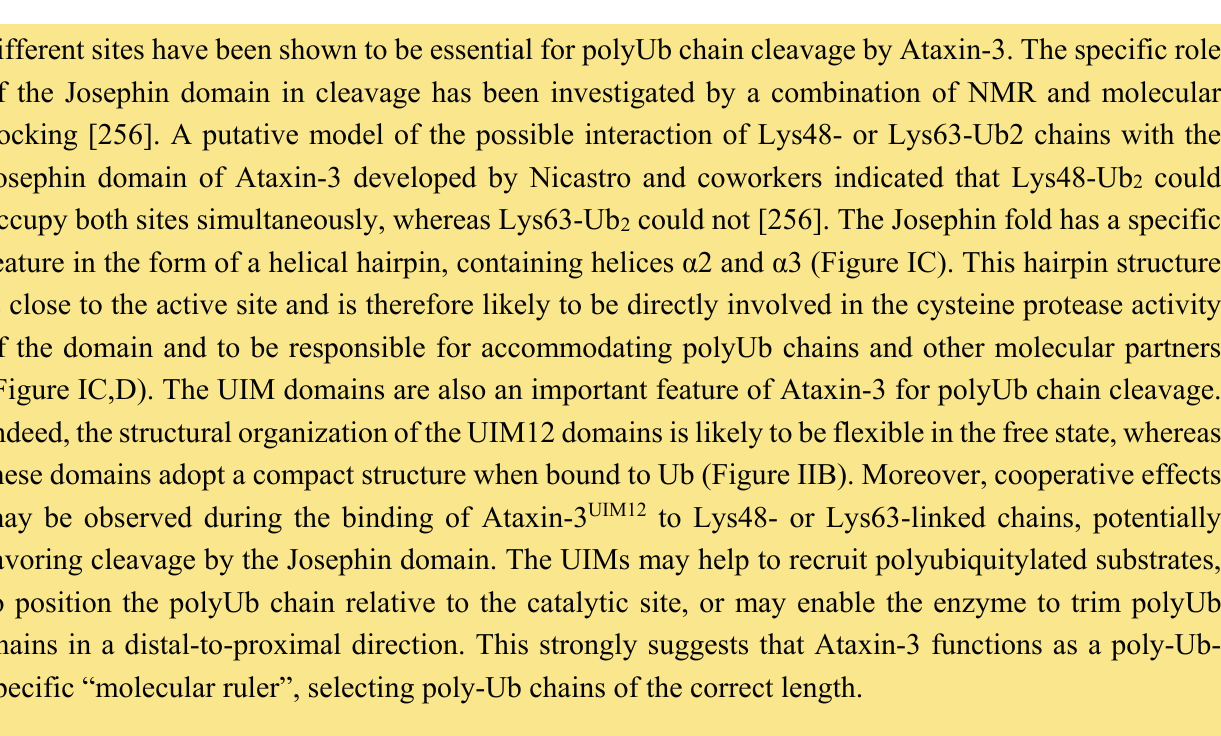
Figure II. Structures of the Ataxin-3 Josephin/Ub ( A ) binary complexes, showing the two binding sites available on the Josephin domain. ( B ) Upon binding to polyUb chains, the Ataxin-3 UIM12 domains adopt a compact structure (PDB code 2KLZ). ( C ) Structure of USP7/HAUSP (PDB code 1NBF) and CYLD (PDB code 2VHF) in complex with Ub. The positioning of Ub on CYLD arises from the structural alignment of USP7/HAUSP-Ub on CYLD. The absence of Fingers domain and an extended loop near the catalytic domain renders CYLD specific toward UbK63 chains and prevent UbK48 from